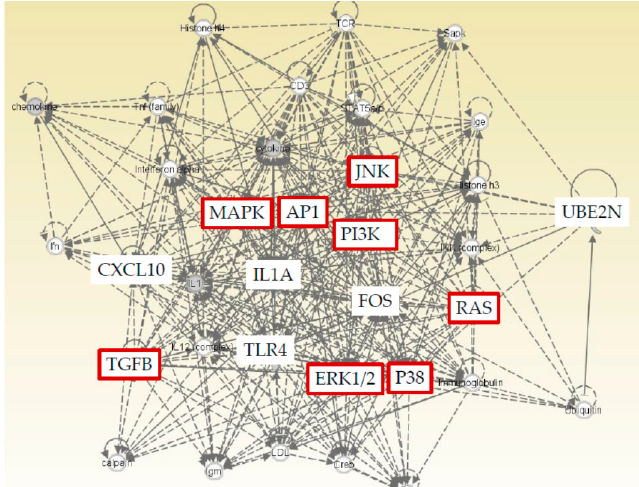
Figure 5. Ingenuity Pathway Analysis (IPA) of five genes (CXCL10, FOS, UBE2N, IL1A, and TLR4) that are commonly regulated by both regorafenib and lenvatinib showed a close association with cell proliferation signaling pathways (red color).